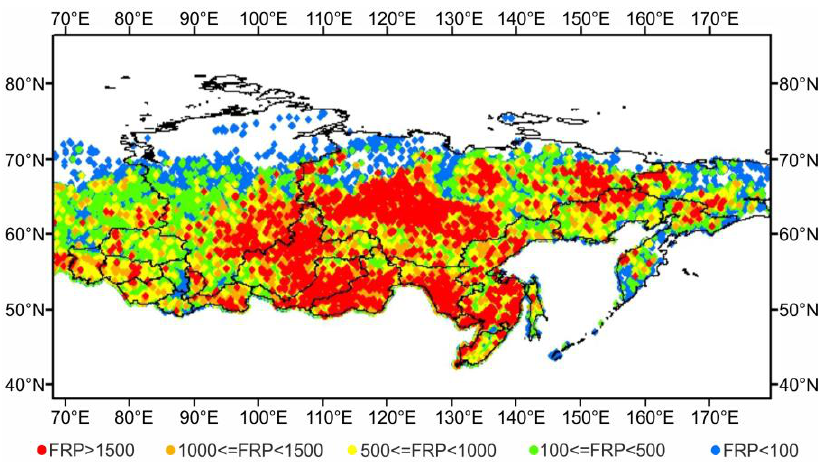
Figure 2. Spatial distribution of wildfire hotspots of various intensities for the territories of the Siberian and Far Eastern Federal Districts detected by the MODIS instrument during fire seasons (April–October) in